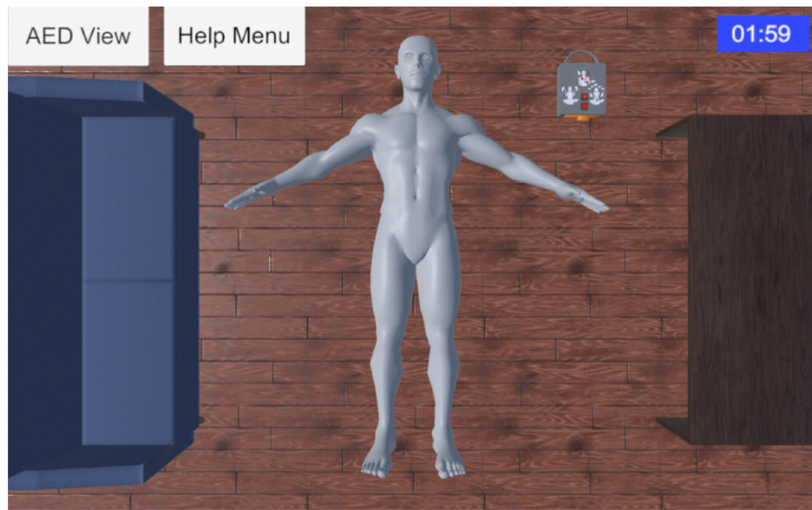
Figure 4. Body View and starting view in the